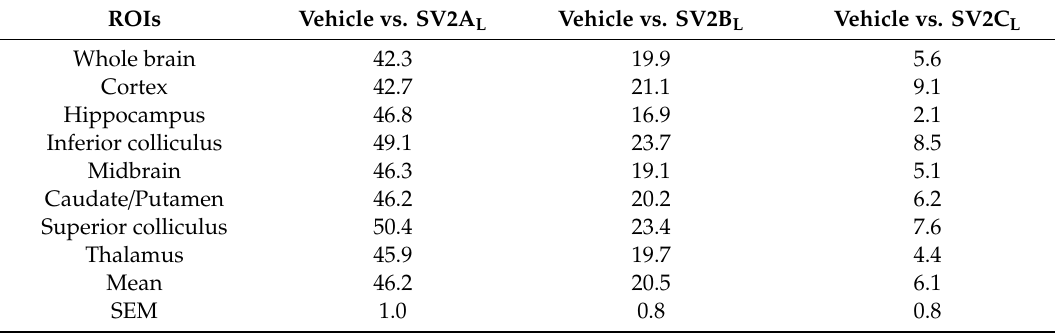
Table 2. Illustration of the impact induced by the blocking experiments, expressed as percentage of reduction calculated from the mean Vt values (n = 5) for the eight selected ROIs.